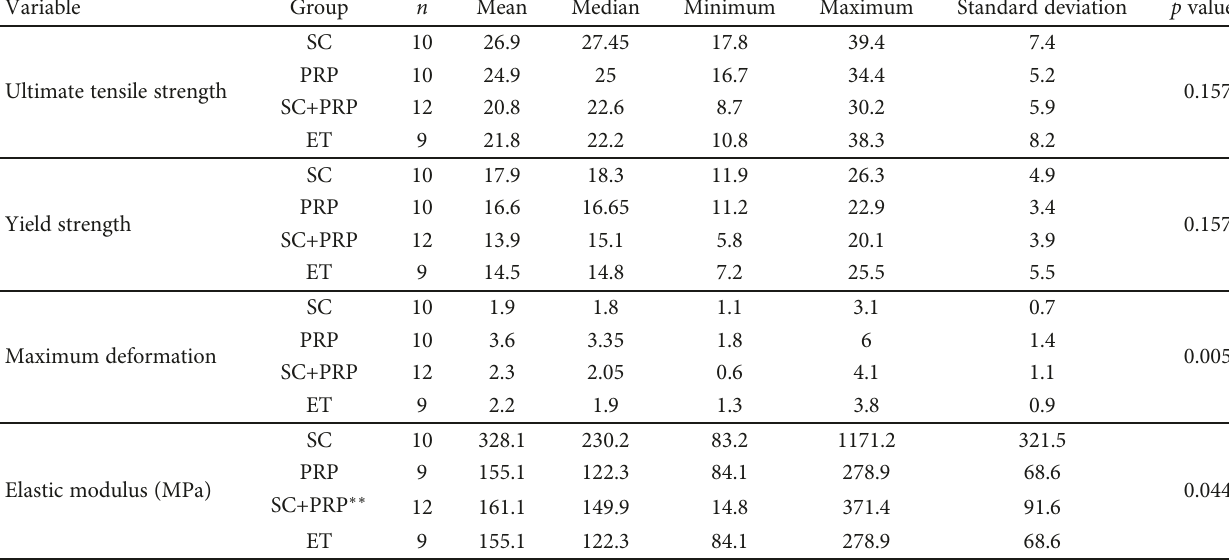
Table 1: Ultimate tensile strength, yield strength, maximum tensile deformation, and elastic modulus as determined via biomechanical testing.